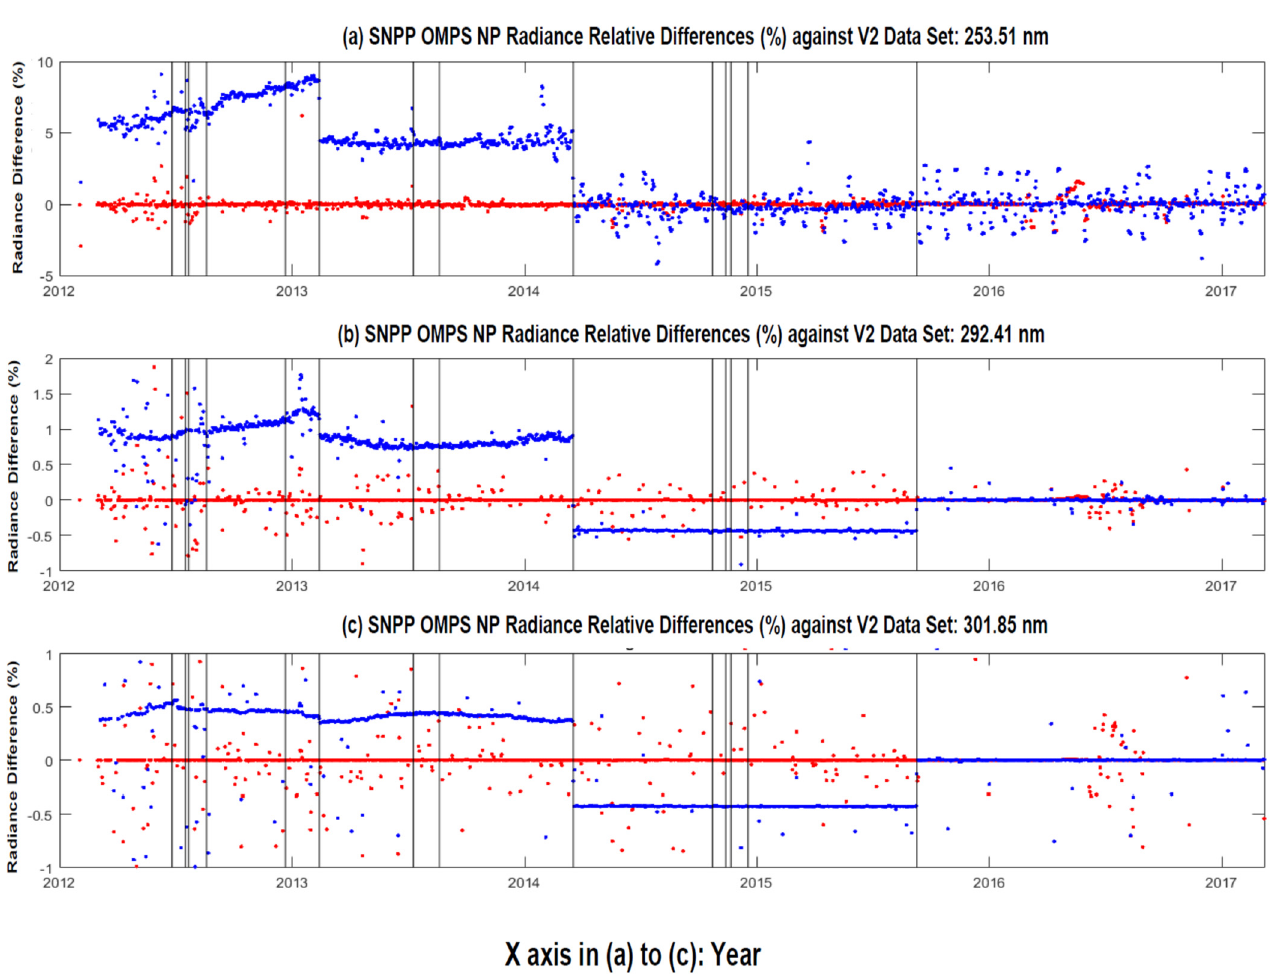
Figure 7. Time series of long–term SNPP OMPS NP averaged relative radiance differences at three wavelengths (253.51 nm, 292.41 nm, and 301.85 nm) over the tropic areas (20°N~20°S) for the operational and 𝑣 1 reprocessed data sets against the 𝑣 2 data set by using (6); ( a ) 253.51 nm, ( b ) 292.41 nm, ( c ) 301.85 nm.